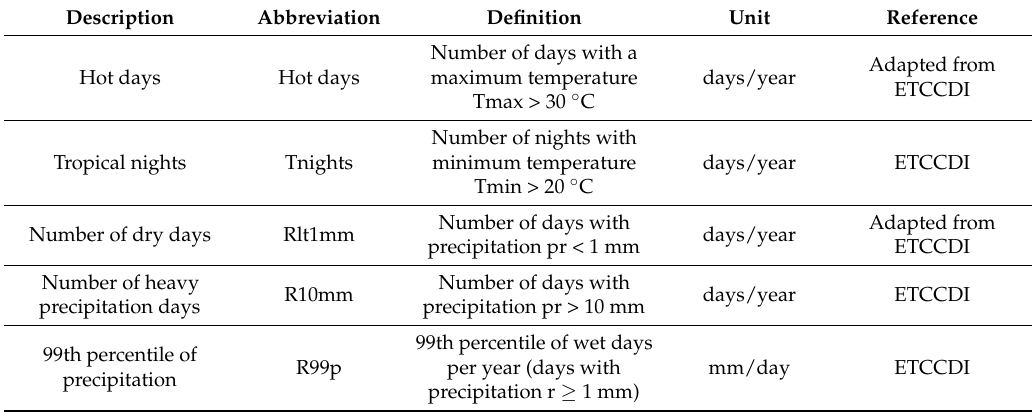
Table 1. Table of indices and their definition according to or adapted from the Expert Team on Climate Change Detection and Indices (ETCCDI)